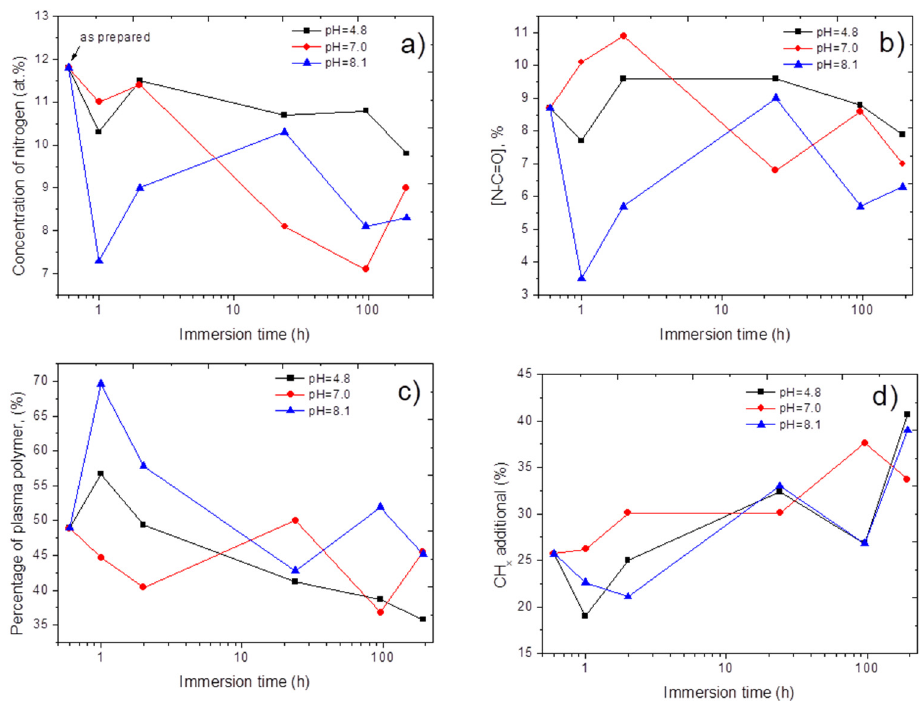
Figure 4. The evolution of nitrogen atomic concentration ( a ), concentration of amide contribution N-C=O ( b ), concentration of plasma polymer contribution ( c ), and hydrocarbons CH x ( d ) environments derived from C1s XPS analysis as a function of immersion time at various pH.